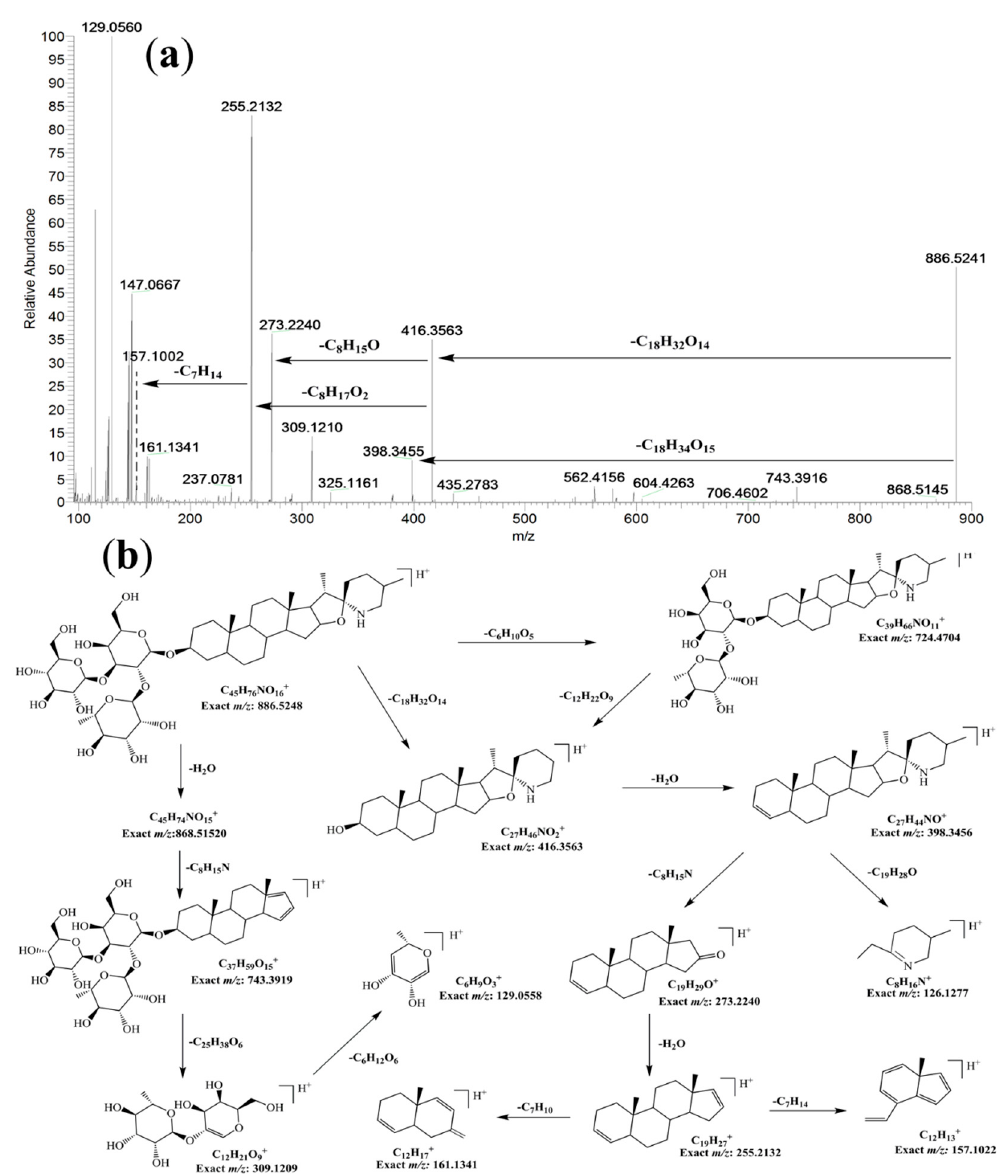
Figure 1. The HR-Orbitrap MS / MS spectrum ( a ) and proposed fragmentation pathway ( b ) of 5,6- dihydrosolasonine.